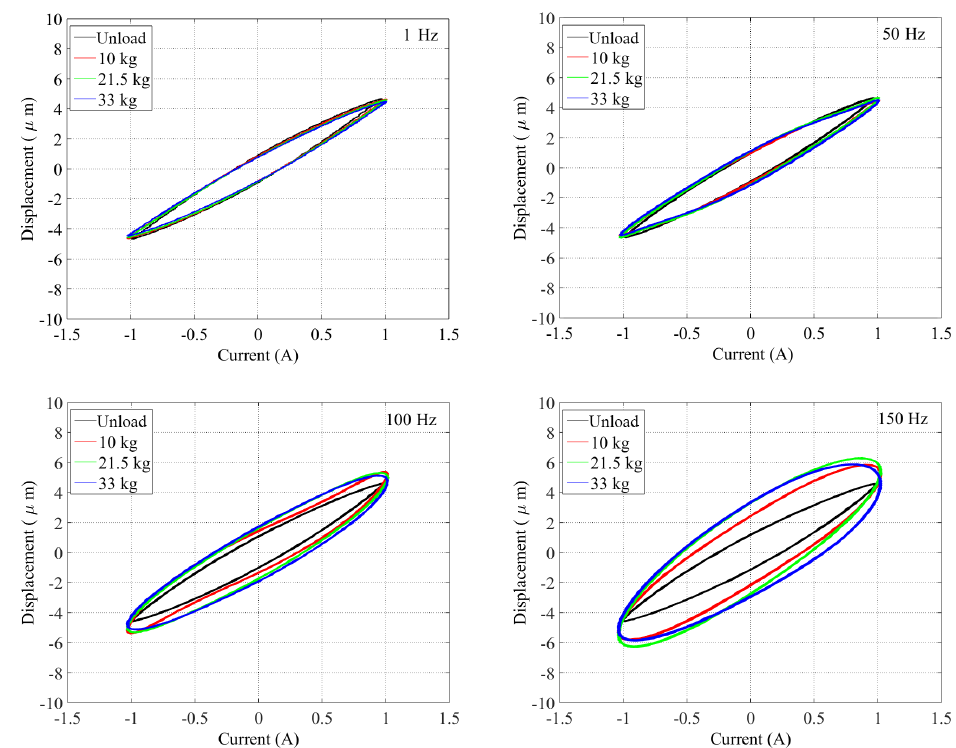
Figure 3. Major-loop hysteresis characteristics of the magnetostrictive actuated system under operating loads (0–33kg) and excitation frequencies